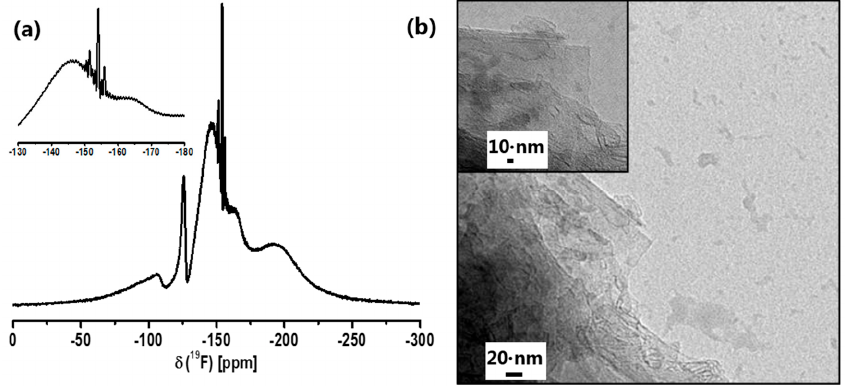
Figure 5. 19 F liquid NMR spectrum ( a ) and TEM image ( b ) of Ca 2 AlF 7 sol in EtOH.